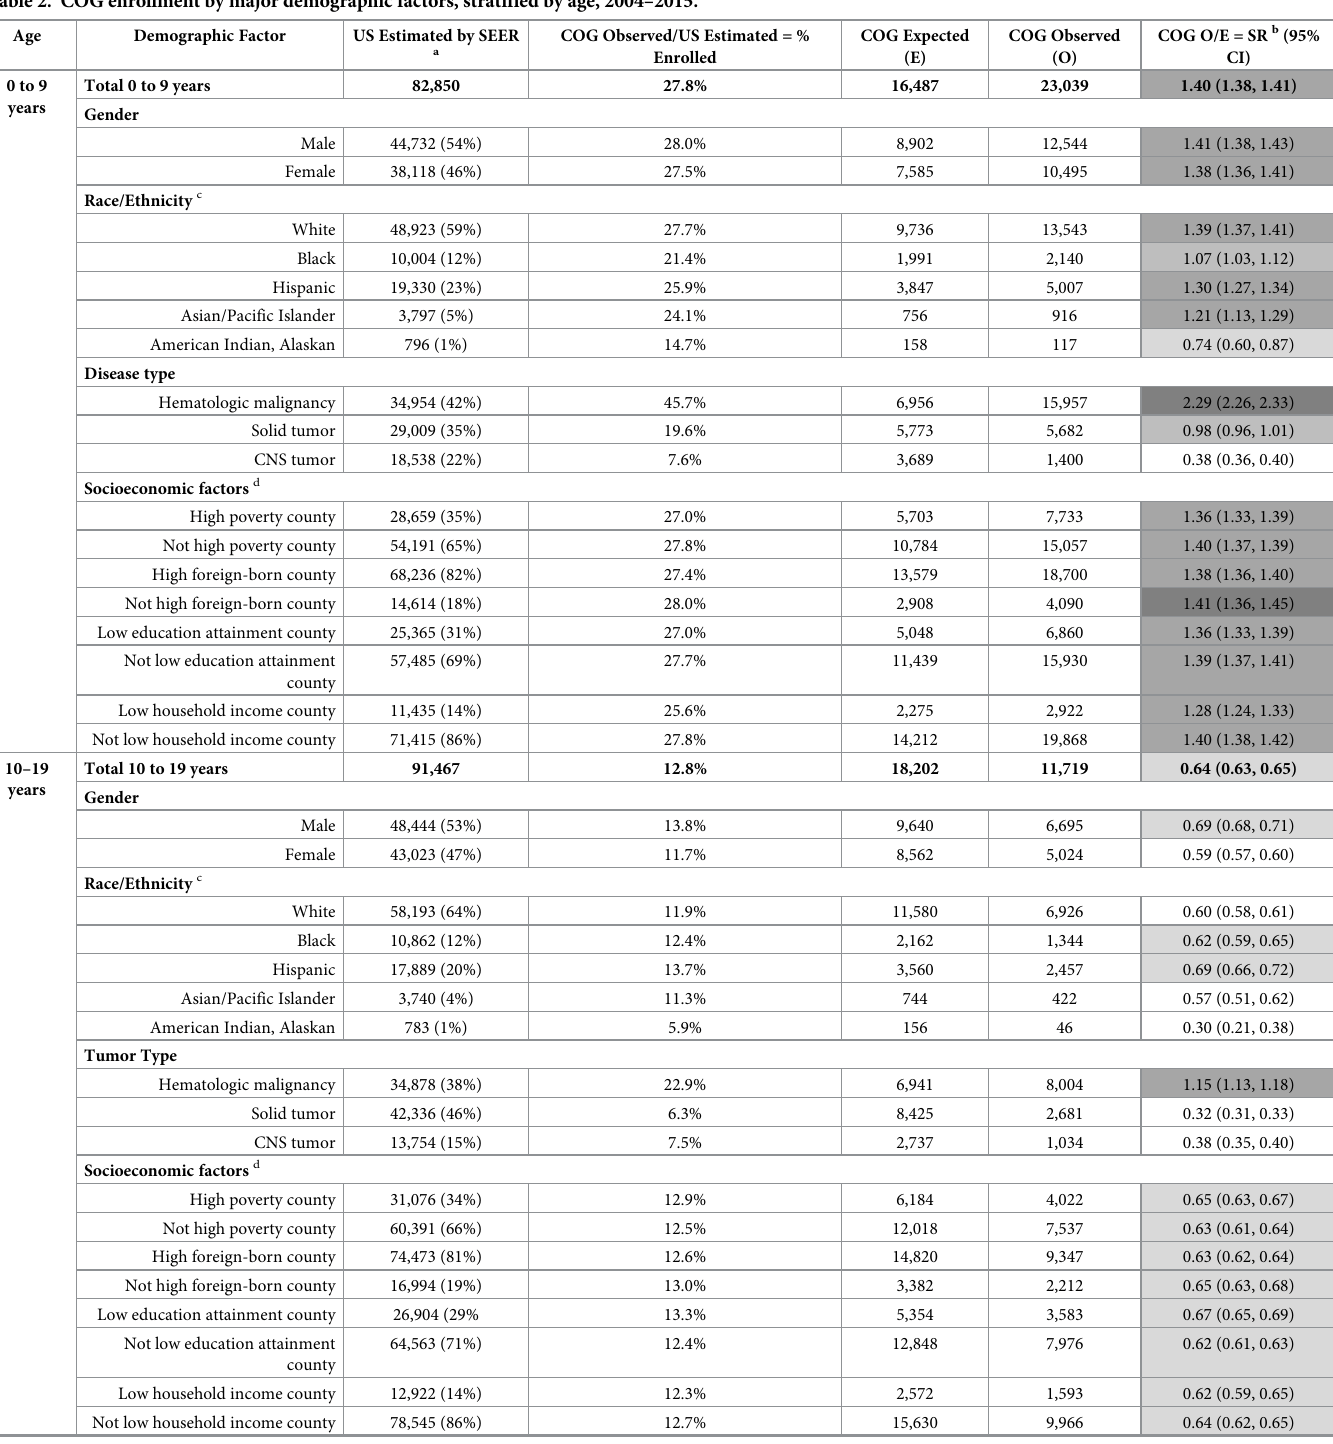
Table 2. COG enrollment by major demographic factors, stratified by age,